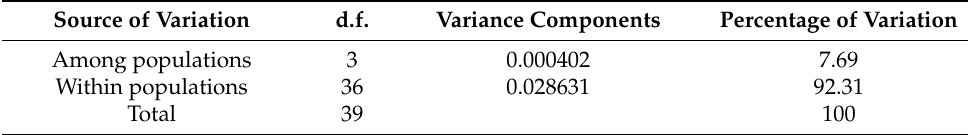
Table 4. Analyses of molecular variance (AMOVA) of H. leucisculus